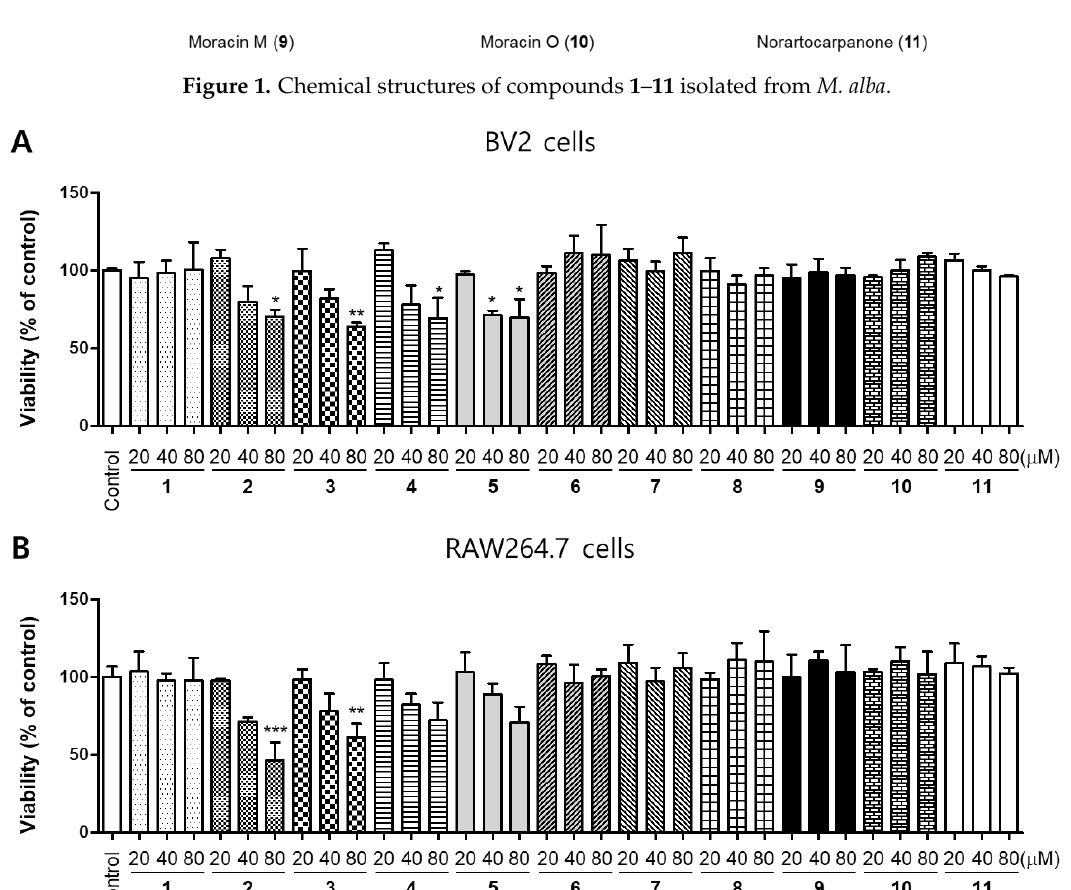
Figure 2. Cytotoxic effects of compounds 1 – 11 isolated from M. alba on BV2 ( A ) and RAW264.7 ( B ) cells. The cells were incubated for 48 h with various concentrations of the compounds, and their viability was determined using MTT (3-(4,5- dimethylthiazol-2-yl)-2,5-diphenyltetrazolium bromide) assay. Error bars represent mean ± standard deviation of three independent experiments . * p < 0.05, ** p < 0.01 , *** p < 0.001 compared with the control group.